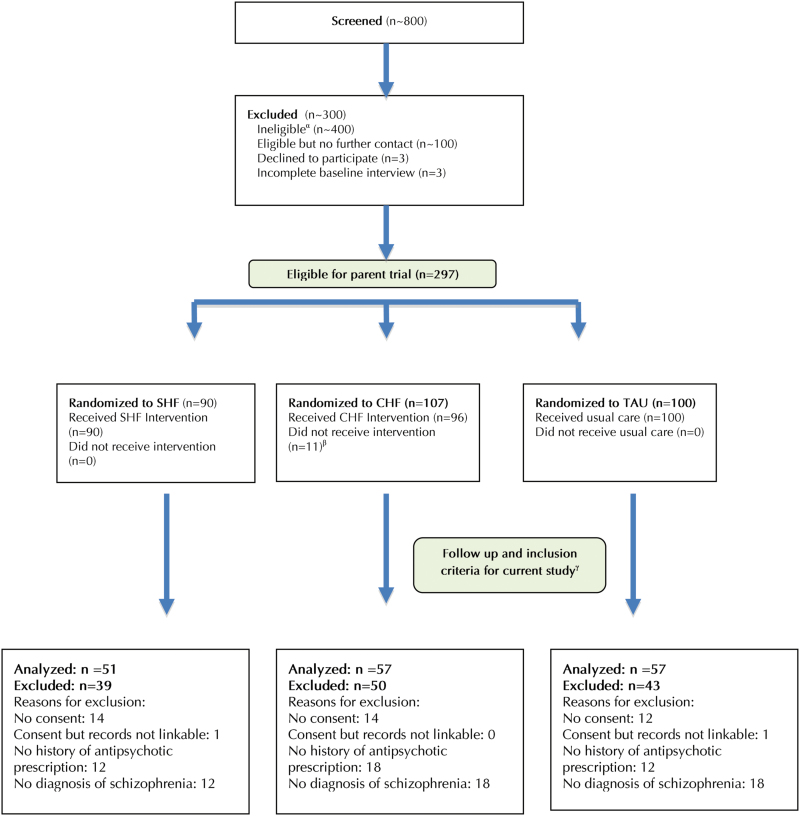
Participant flow through screening, assessment, and allocation to study interventions. αIncludes approximately 100 participants deemed ineligible via an informal telephone screen, 94 participants who were ineligible after formal in-person screening, and 200 participants who were eligible for a separate study that included participants with less severe needs. βIncludes 11 participants who could not be located after randomization or who left the study within 1 mo following randomization to intervention. γEligibility criteria for the current study included participant consent to access of administrative health data, linkable health records, initiation of antipsychotic prescription prior to recruitment, and ICD-9 diagnosis of psychotic disorder. All eligible participants were followed to the study end date or death (no loss to follow-up). CHF, congregate Housing First; SHF, scattered-site Housing First; TAU, treatment as usual.